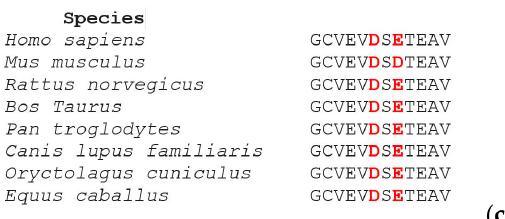
Figure 7. Display of a trimeric hNa v β 1 model. ( a ) Na v β 1 trimer seen top-down ( b ) close-up view from above of the alleged hotspot ( c ) Aligned sequences from Mammalian species. Negatively charged residues are identical to Asp25 and Glu27 on Na v β 1 from Homo sapiens ; white box: analysis area; green dotted lines: computed repulsion of charges; sticks: negative charged residues; sticks and balls: residues that form a possible hydrophobic patch. Data generated by Chimera Alpha 1.14 [61].